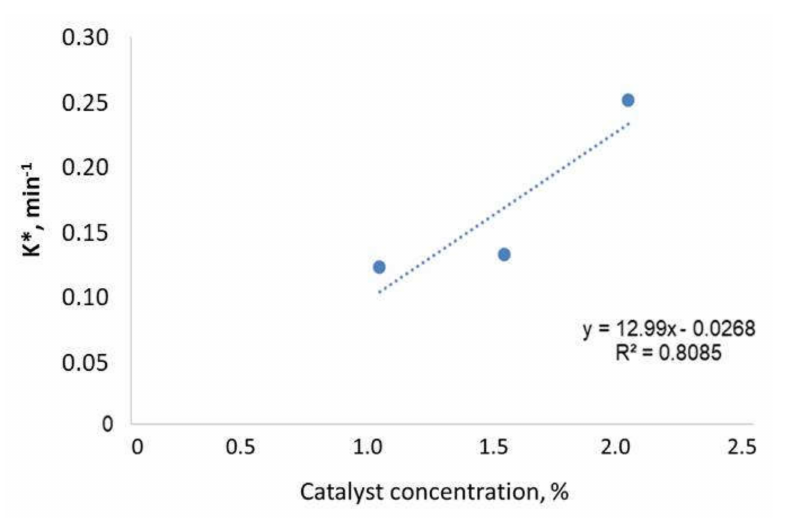
Figure 9. Dependence of k* with catalyst concentration (pseudo-first reaction order).